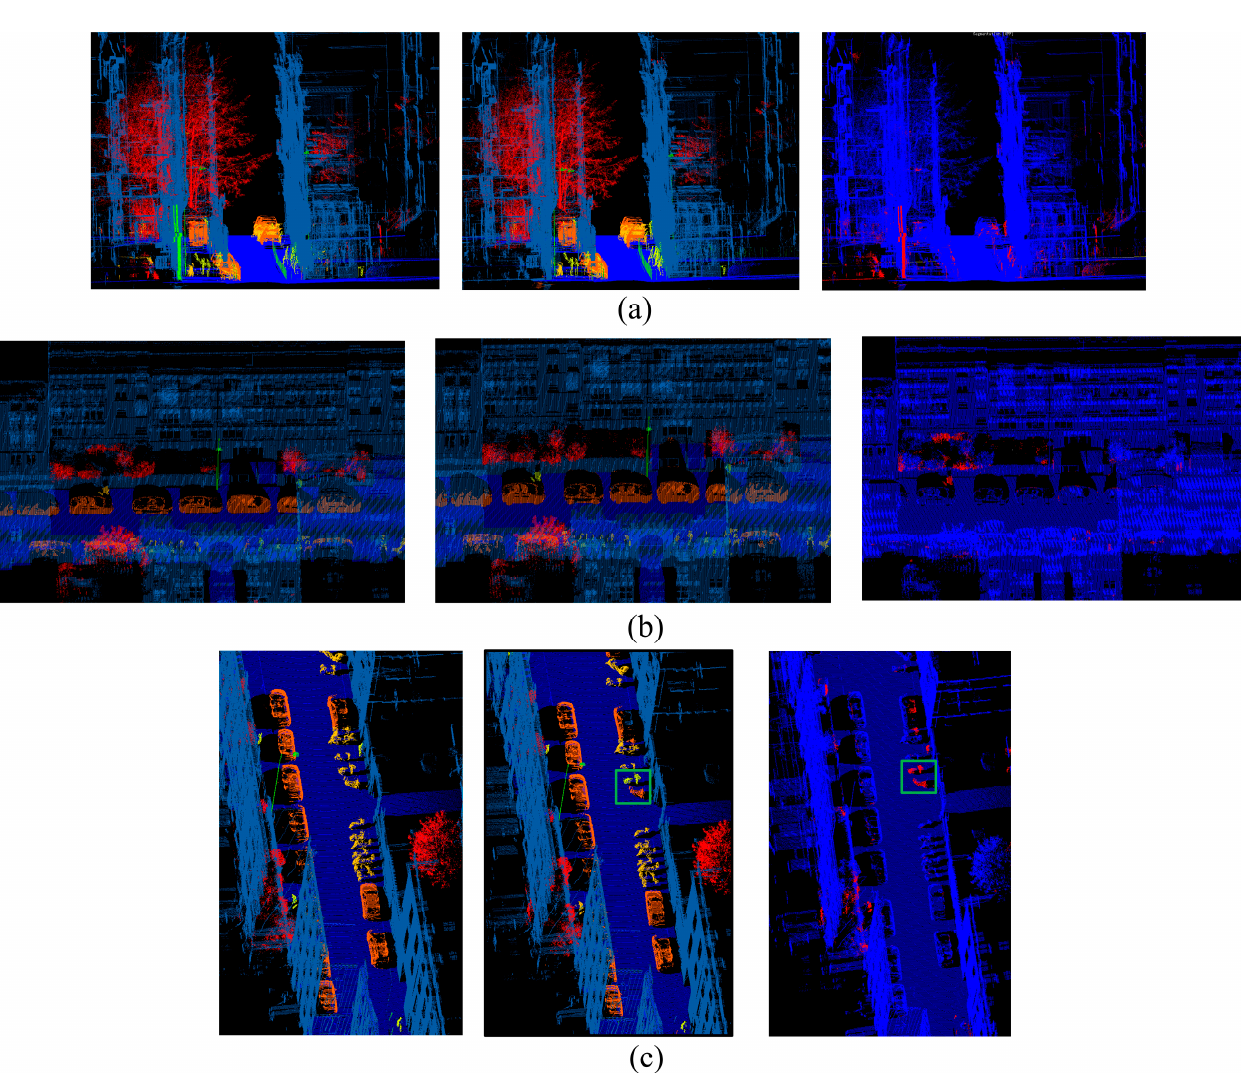
Figure 10. Different scene of classification results of the proposed method in the Paris-rue-Cassette dataset, from left to right are the classification results, the truth-ground and the incorrect points. ( a ) Façade scene. ( b ) Intersection objects scene. ( c ) Car, motorcycle and pedestrian scene.